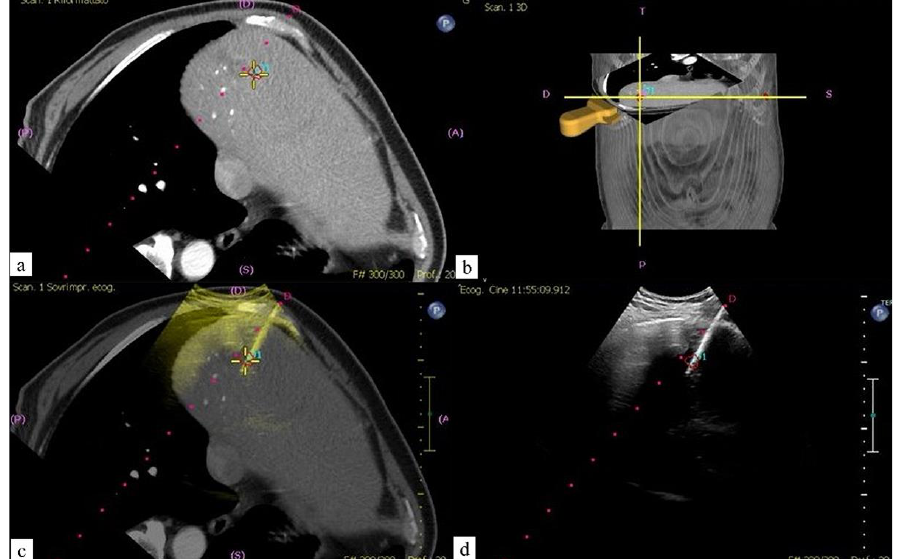
Figure 2. Sixty-four-year-old male patient with CRC liver single metastasis: percutaneous MWA. ( a , b ) Contrast enhanced CT (CECT) post-processed images with ablation planning; ( c ) fused images obtained using CECT and real time US during MW probe positioning; ( d ) US imaging confirmation.